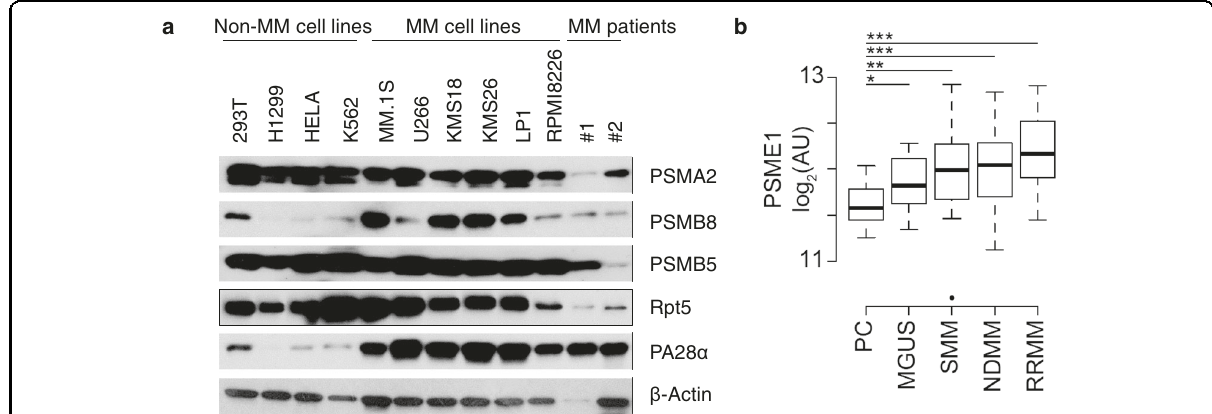
Fig. 1 PA28 α is upregulated in human multiple myeloma cells. a Western blot of proteasome subunits expression on cell lysate from a variety of cell lines and primary MM cells, β -actin as a loading control. b Boxplot of PSME1 expression data in normal plasma cells (PC, n = 15), monoclonal gammopathy of undetermined signi fi cance (MGUS, n = 22), smoldering multiple myeloma (SMM, n = 24), newly diagnosed multiple myeloma (NDMM, n = 73), and relapsed/refractory multiple myeloma (RRMM, n = 28) from Chng et al. 25 . * P < 0.05, ** P < 0.01, *** P < 0.001, determined using linear regression with disease stage as a